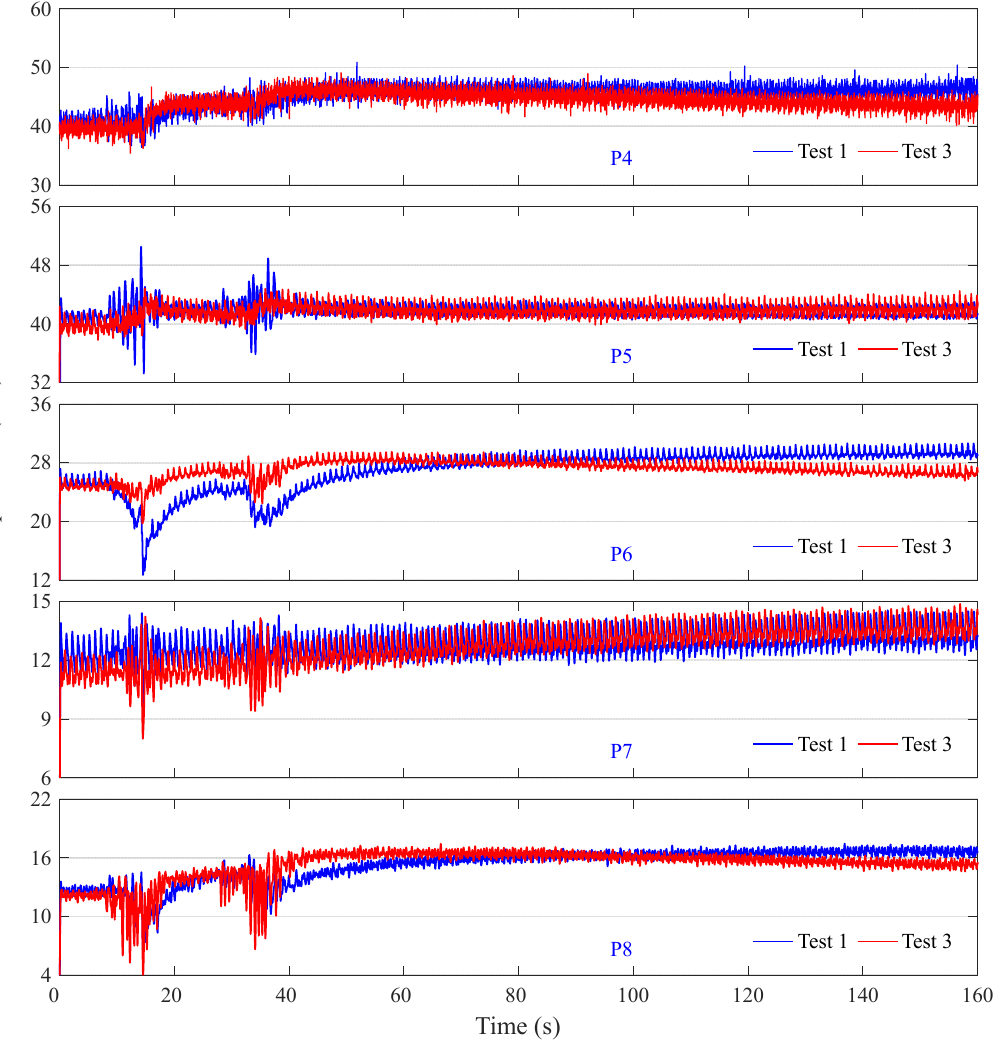
Figure 17. Comparison of pore pressure responding in the coral sand foundation in Test 1 and Test 3.